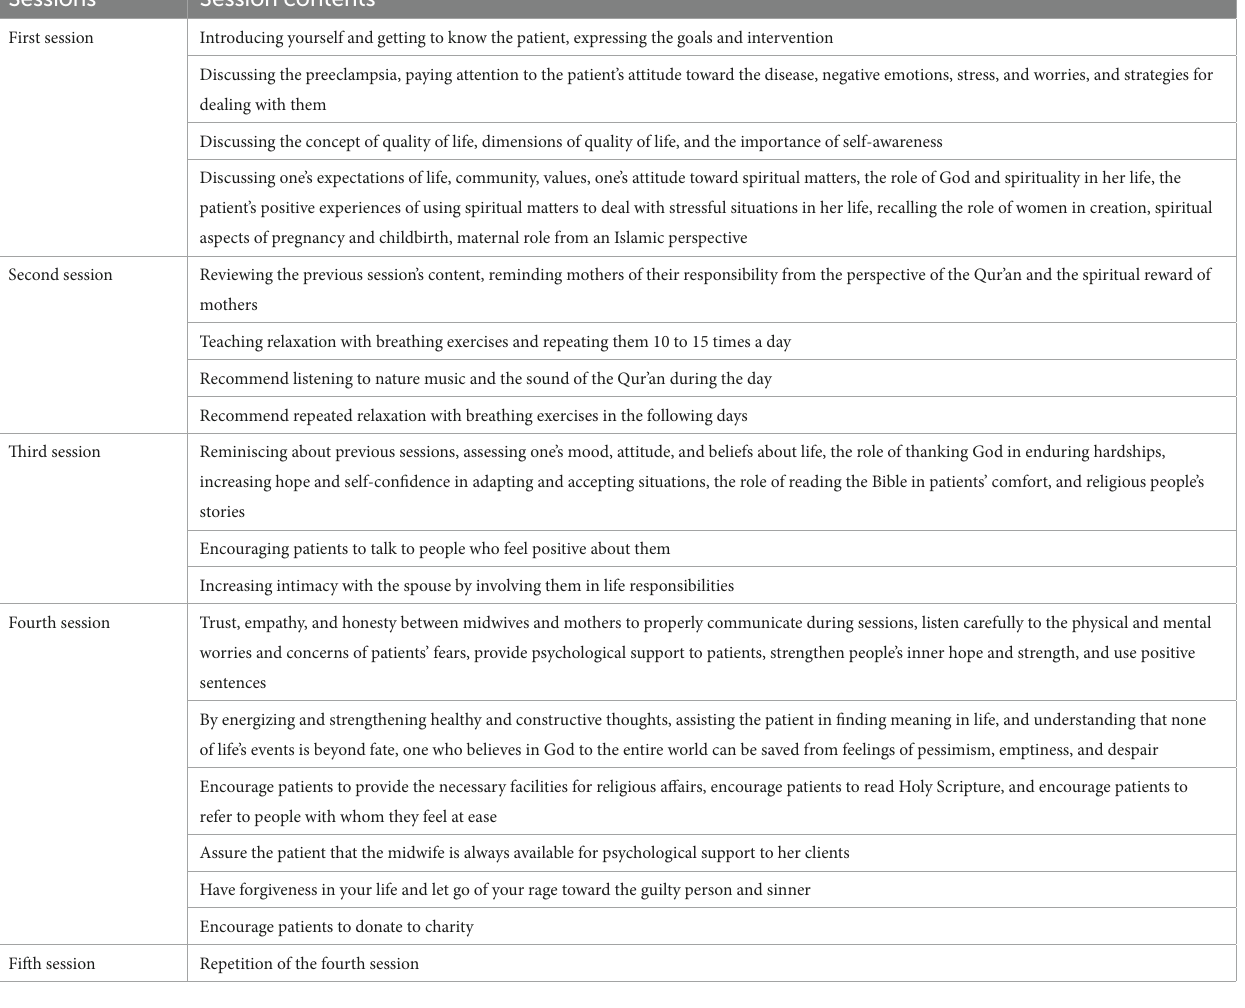
TABLE 1 Spirituality-oriented counseling session